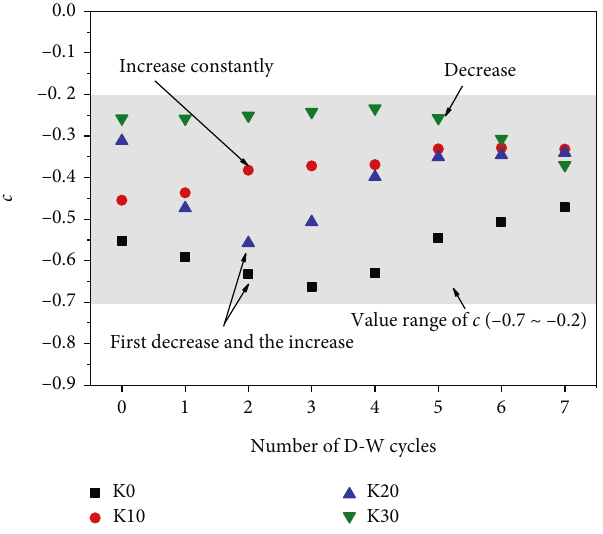
Figure 22: Fitting parameter “ c ” versus D-W cycles number.